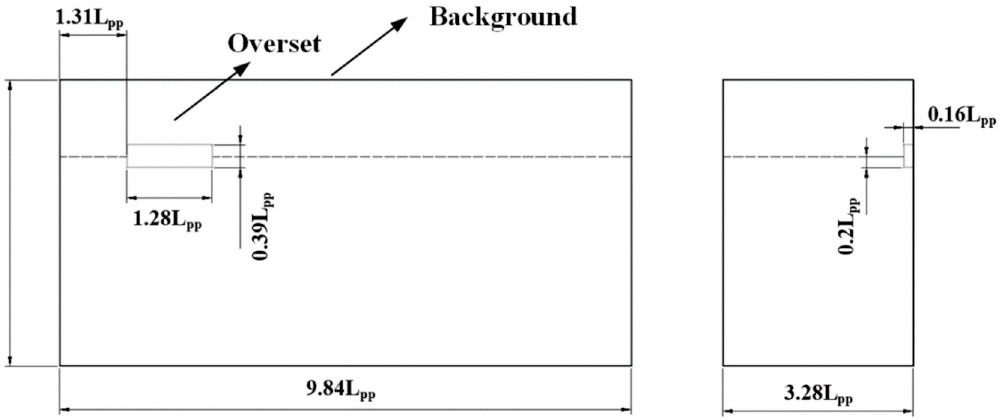
Figure 3. The dimensions of the CFD numerical tank for two regions.